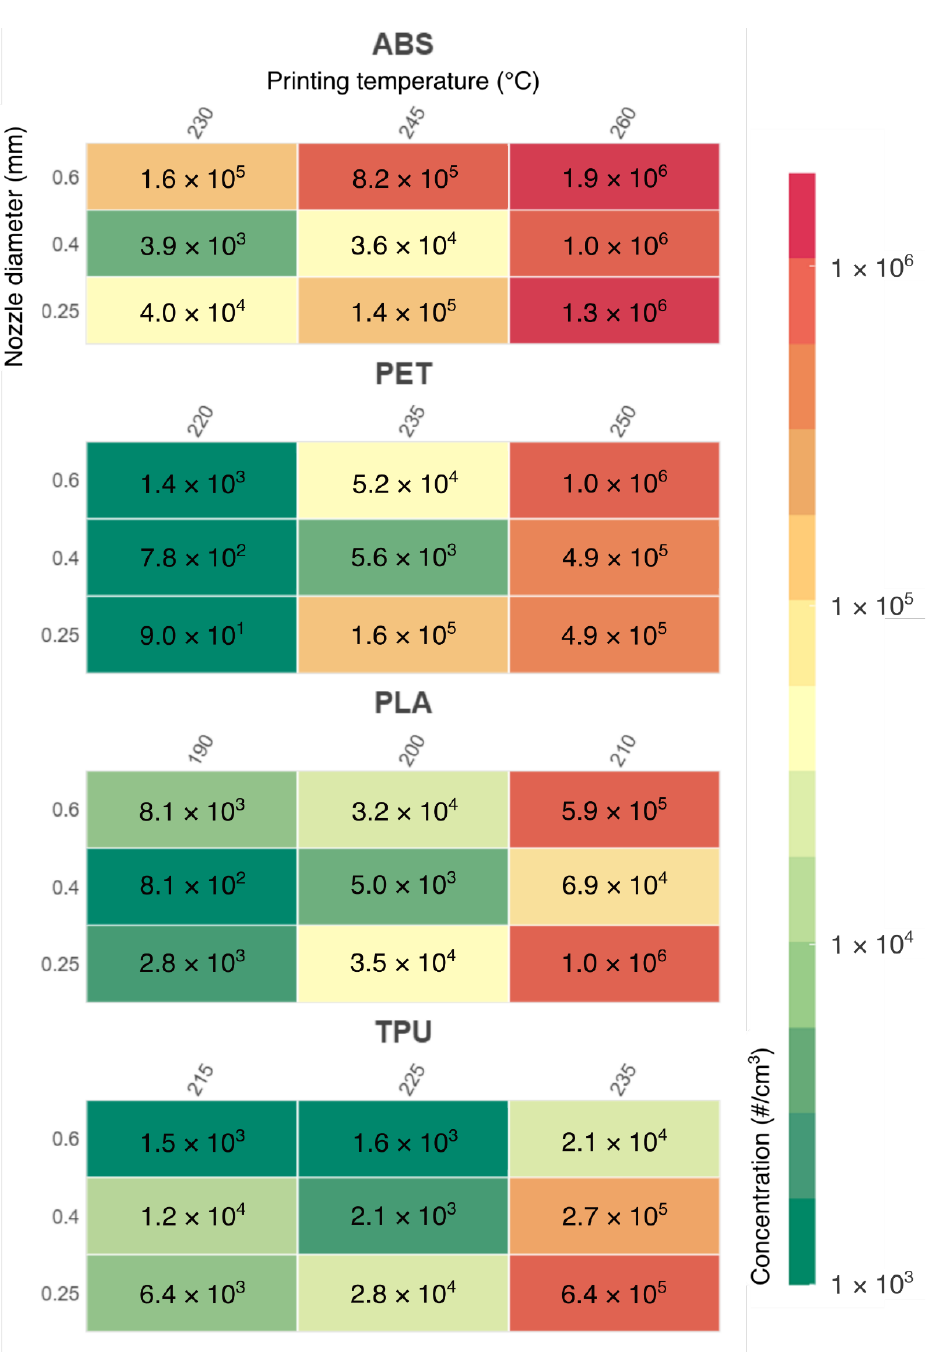
Figure 6. Maximum total particle concentration during the printing process for all measured configurations. The color bar ranges from 1 × 10 3 particles/cm 3 (almost no nucleation) to 1.9 × 10 6 particles, achieved during the printing of the ABS filament.